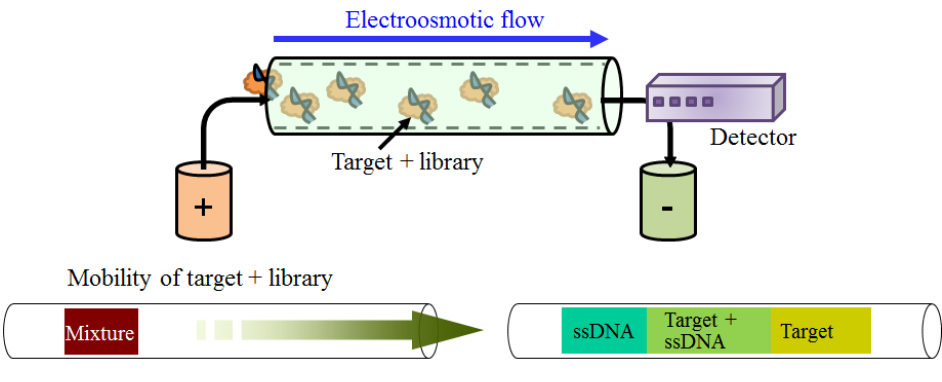
Figure 4. Fundamental principle of the selection step using CE. Aptamers are selected based on the difference in mobility due to charge and